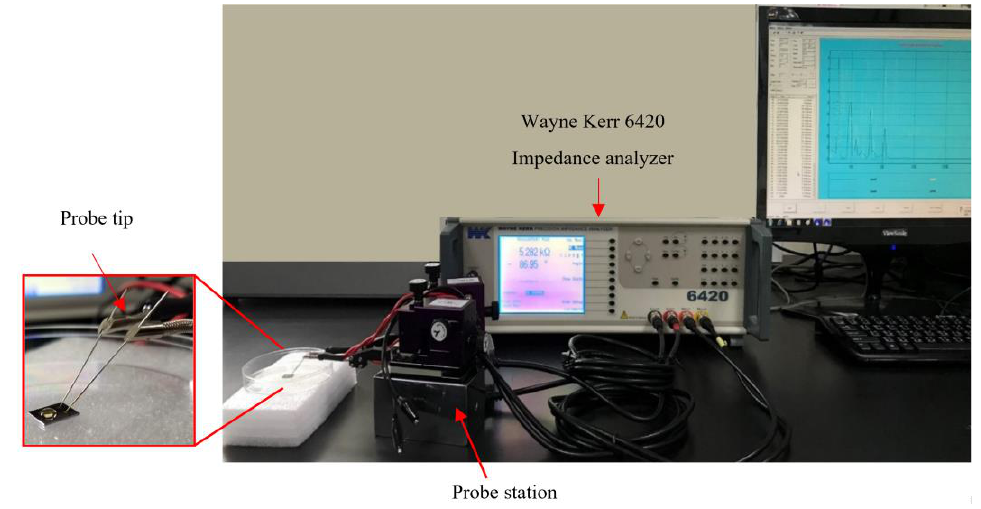
Figure 3. Experimental setup for impedance-capacitance spectrum measurements.